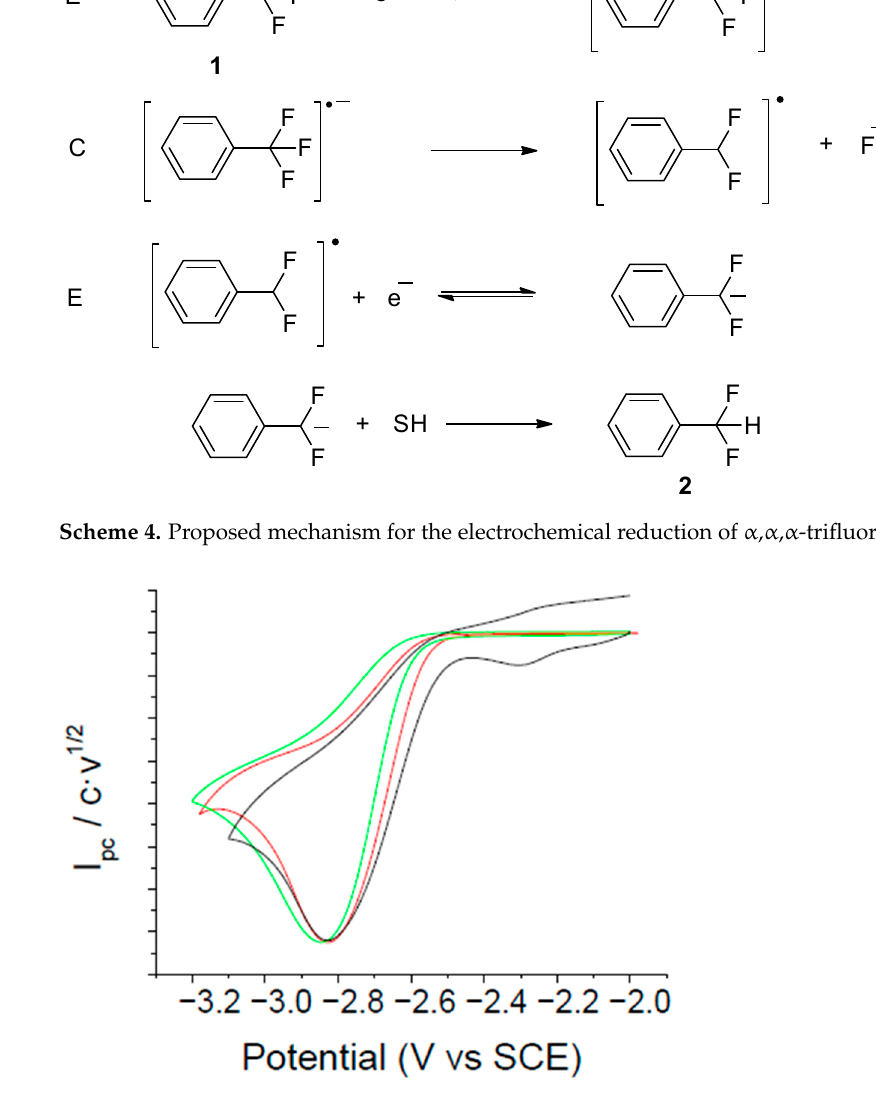
Figure 3. Cyclic voltammetry of 24 mM of 1 in BMPyr TFSI with WE GC (green line), Ag (red line), Cu (black line), CE Pt and RE SCE. Scan rate: 0.3 V·s − 1 .